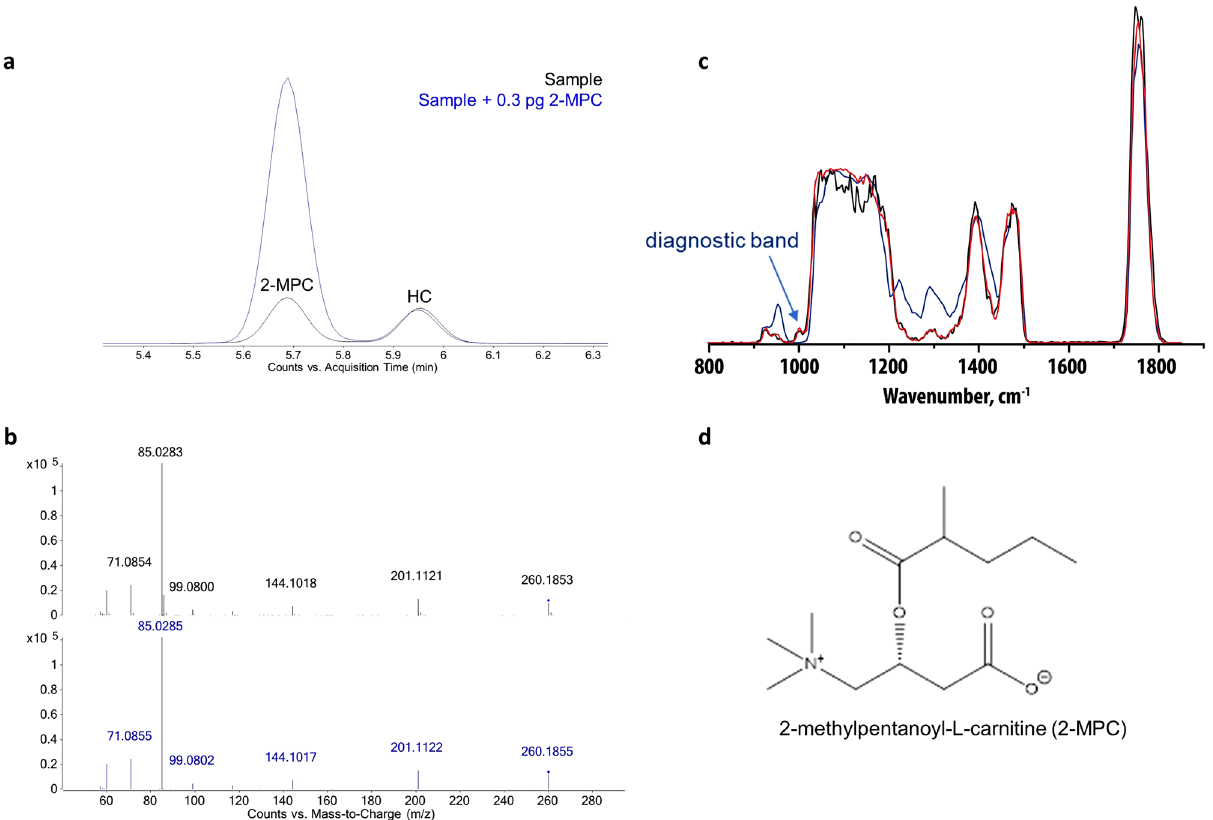
Figure 2. Structure confirmation of 2-methyl-pentanoyl-carnitine. ( a ) Extracted ion chromatograms of co-injection experiment of the synthetic 2-MPC spiked to a positive plasma extract (blue) in comparison to the positive plasma extract (black). ( b ) MS/MS fragmentation comparison of the synthetic and natural molecules (collision-induced dissociation at 20 V). ( c ) IR spectra generated with infrared ion spectroscopy (IRIS) analysis on the protonated ion at m/z 260 from the HPLC purified marker (black), 2-MPC (red) and 3-MPC (blue). ( d ) Structure of 2-MPC.